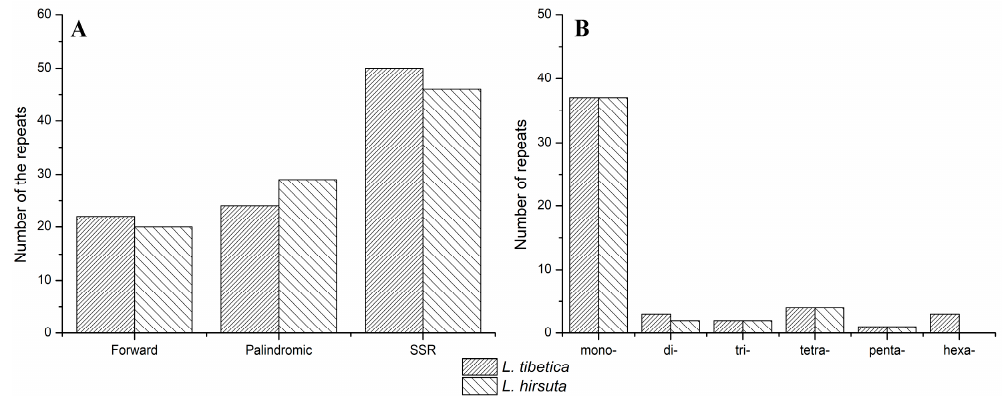
Figure 2. Repeated sequences in Lancea chloroplast genomes. ( A ) Number of three repeat types within chloroplast genomes; ( B ) SSR type distribution within Lancea chloroplast genome.